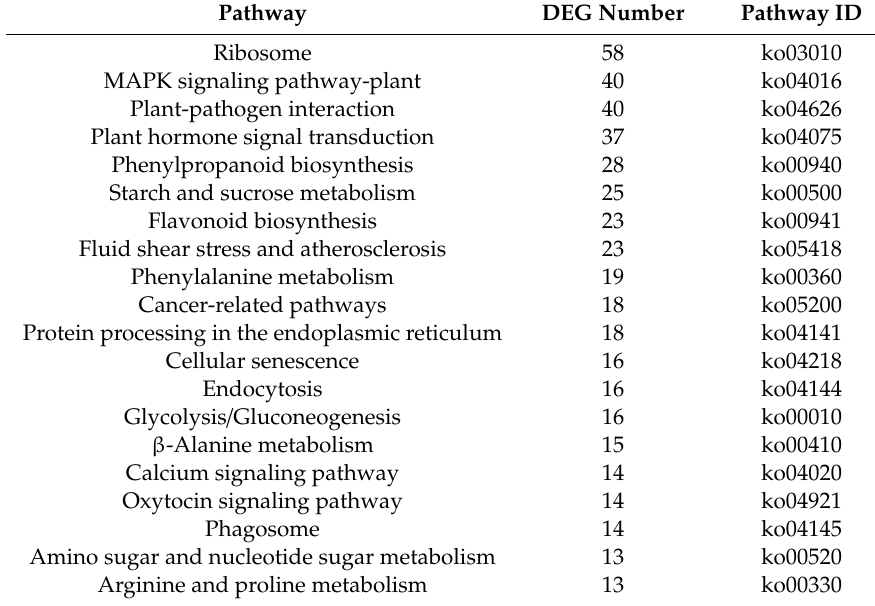
Table 2. Top 20 enriched Kyoto Encyclopedia of Genes and Genomes (KEGG) pathways of upregulated di ff erentially expressed genes